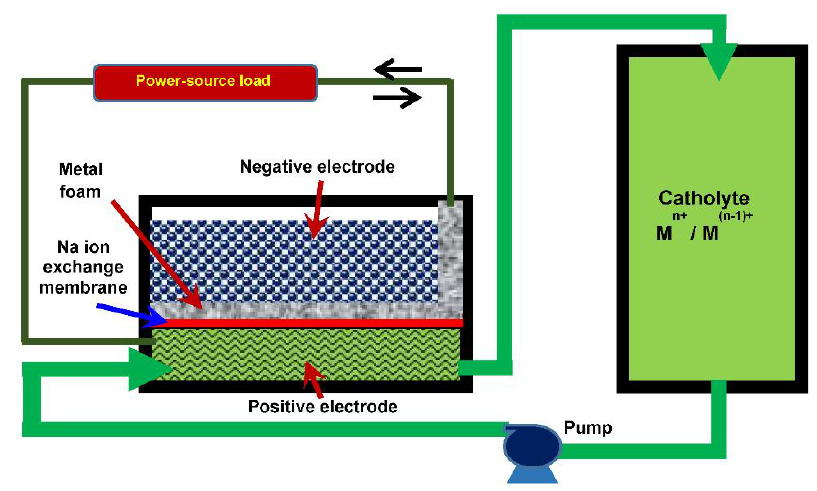
Figure 1. Schematic of a hybrid Na-based flow battery (HNFB) with a floating Na-Cs anode on the Na-ion exchange membrane and a flowing catholyte, operated at room temperature [39–41].